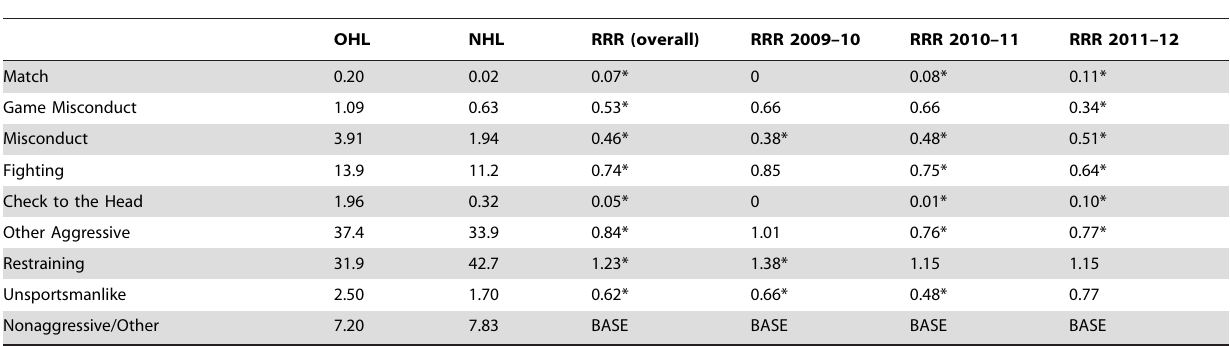
Table 3. Penalties by type in the OHL and NHL.